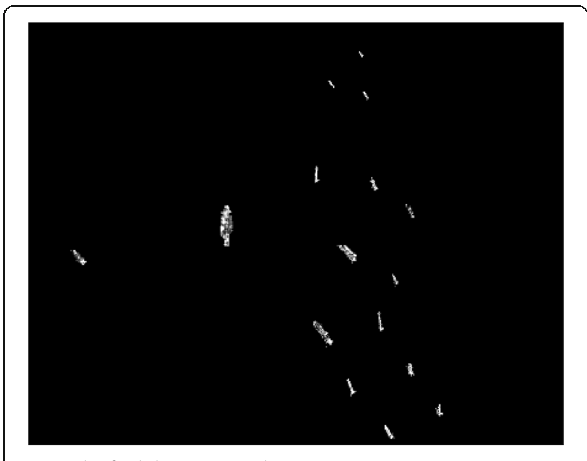
Fig. 8 The final detection result